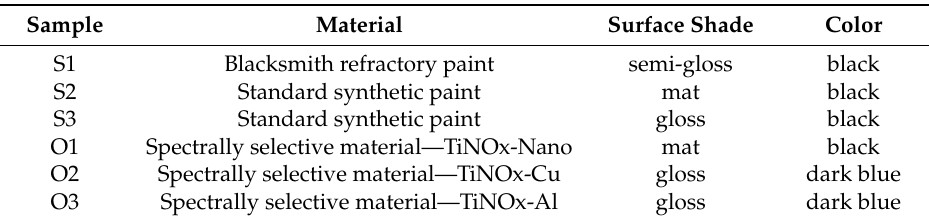
Table 1. Table of measured absorber